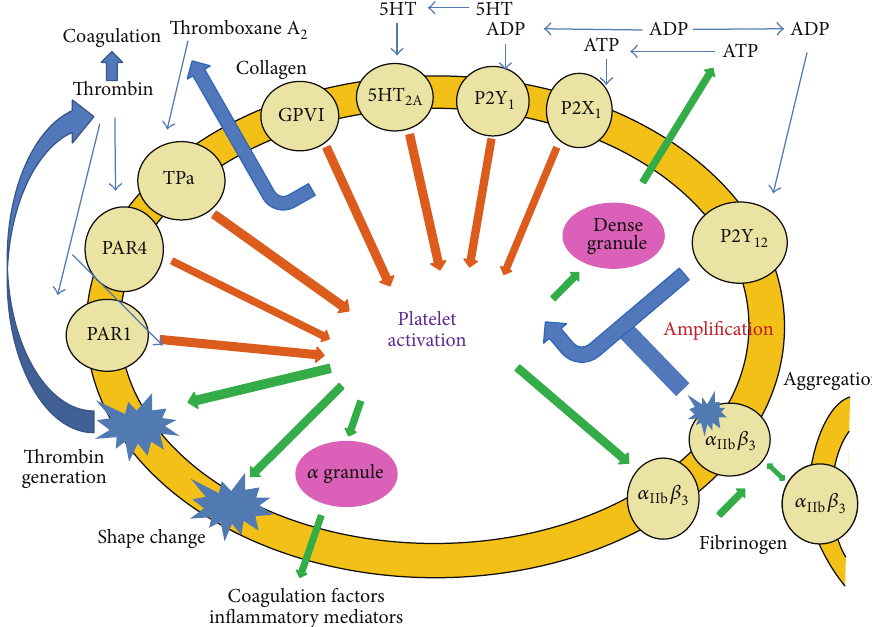
Figure 1: Platelet-activation mechanisms and role of the P2Y 12 receptor. Platelet activation leads to dense-granule secretion of ADP, which activates P2Y 12 , inducing amplification of aggregation, procoagulant, and proinflammatory responses (adapted from Storey, 2008